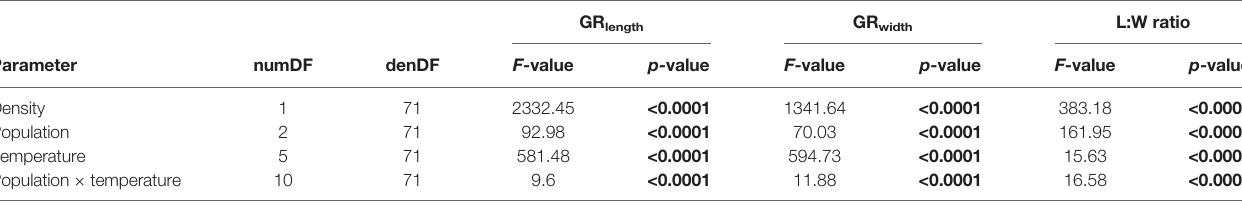
TABLE 4 | Two-way ANCOVA to examine the effects of temperature and population on sporophyte growth parameters of Laminaria digitata on day 21 along a lower temperature gradient (0-15°C) in experiment 2, with sporophyte density on day 7 as a covariate. GR